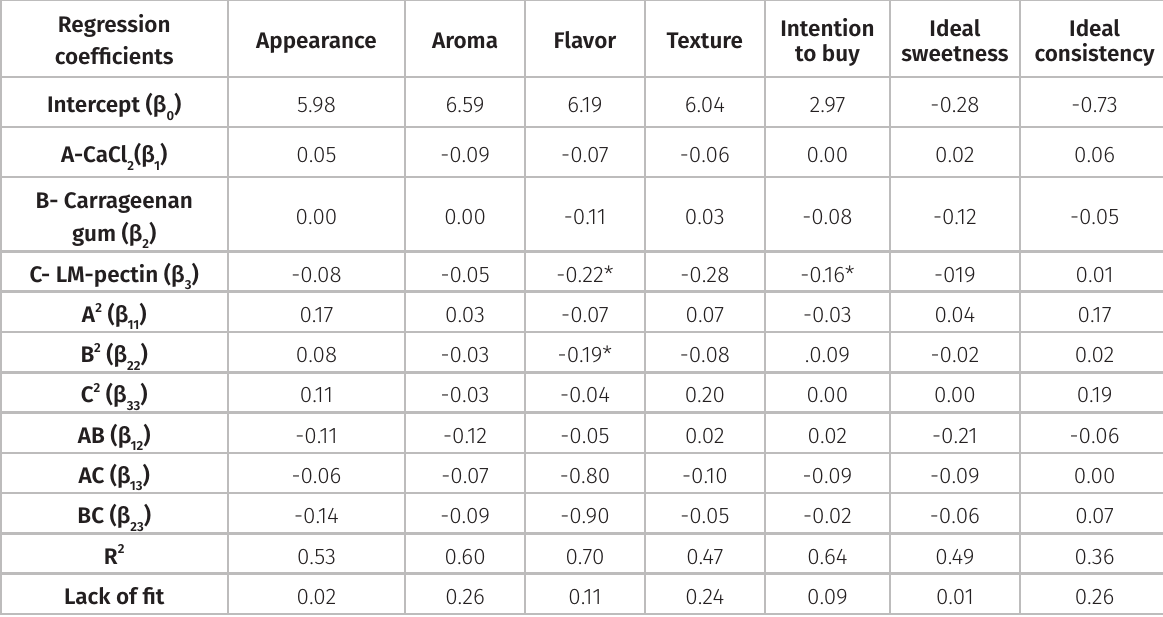
Table III. Regression coefficients for measured responses - acceptance attributes.